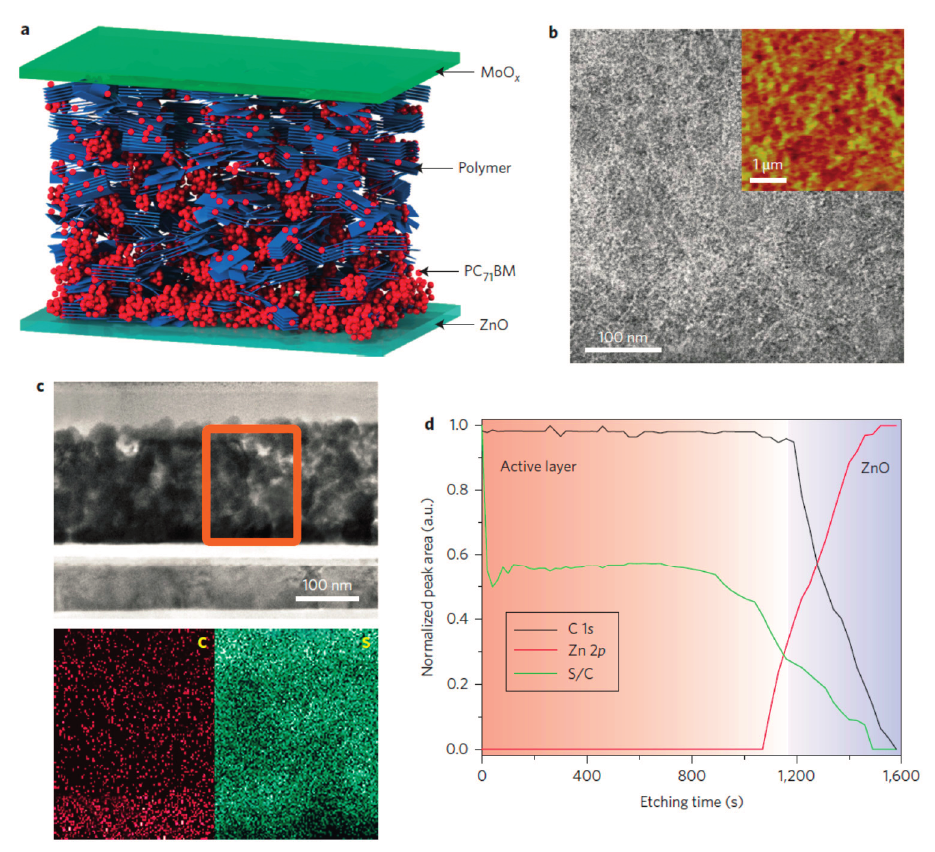
Figure 18. Morphology of an inverted PSC using ZnO cathode IFL, which yields optimal performance. ( a ) Schematic of the PBTI3T:PC 71 BM blend film showing vertical phase gradation with a polymer-rich layer near the MoO x /blend interface and a PC 71 BM-rich layer near the blend/ZnO interface; ( b ) TEM (Transmission electron microscopy) image of a PBTI3T:PC 71 BM blend film. Inset: AFM topographical image; ( c ) TEM